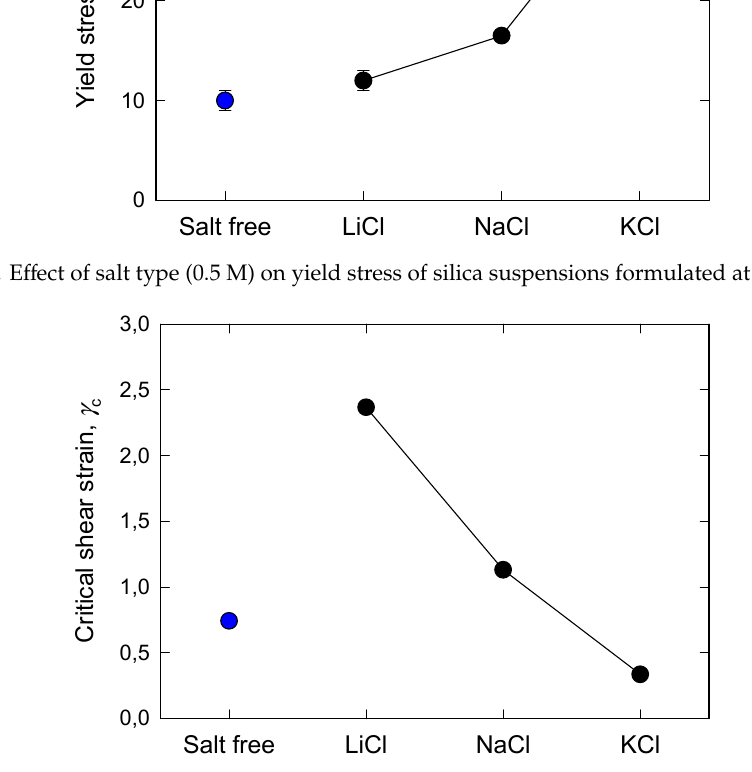
Figure 5. Effect of salt type (0.5 M) on critical shear strain of silica suspensions formulated at natural pH.